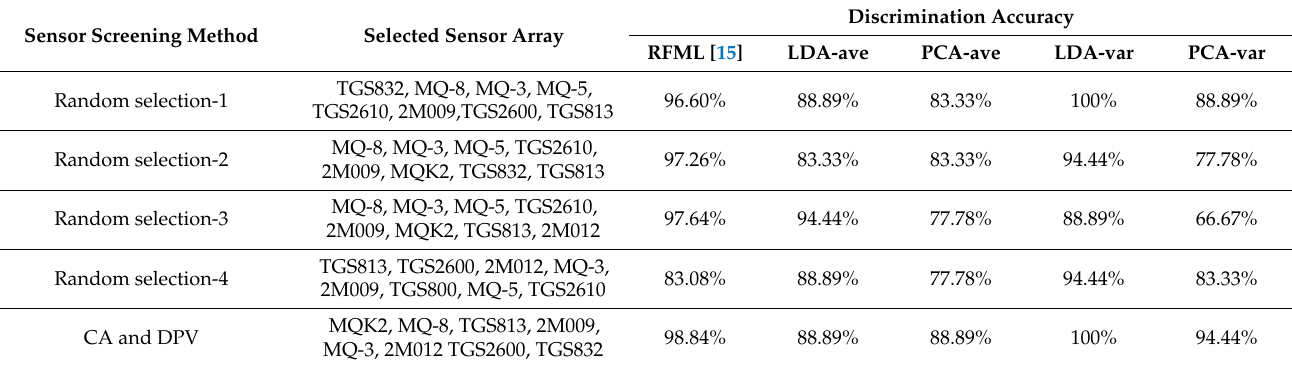
Table 13. Discrimination accuracy of the different 8 sensors screened using different methods. Sensor Screening